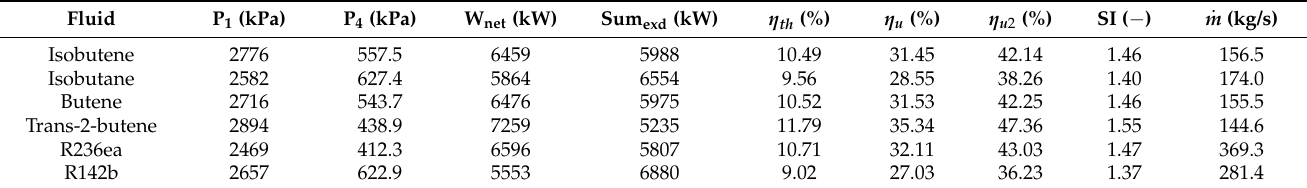
Table 6. Optimized model for different working fluids for 5 ◦ C pinch point for the regenerative ORC model. Fluid P 1 (kPa)